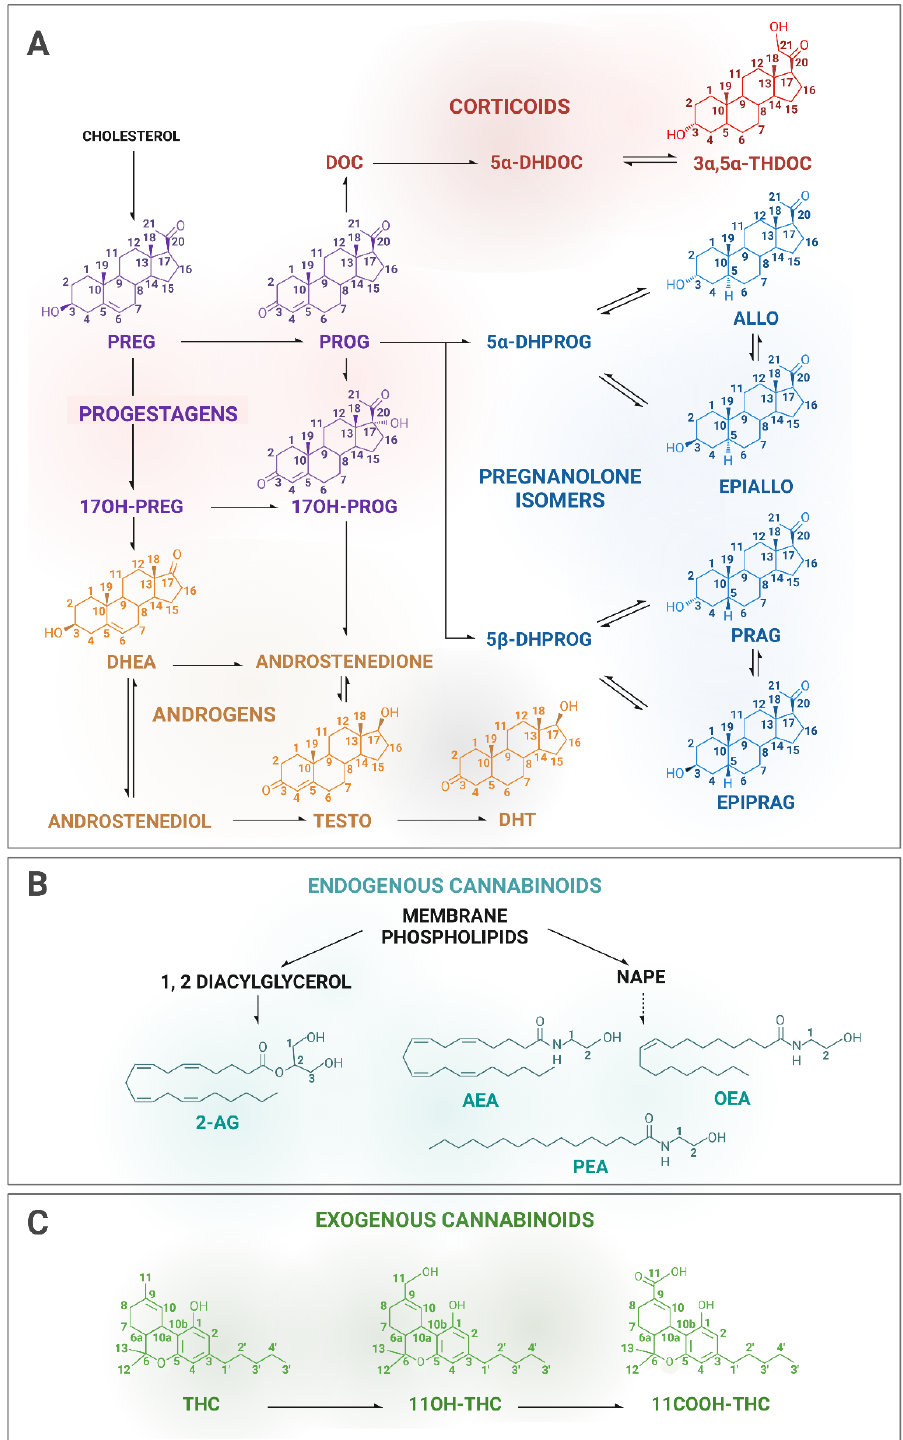
Figure 2. Structures and metabolic pathways of the targeted molecules. The steroids of interest include four progestagens (PREG, PROG and its 17hydroxy metabolite), one corticoid (3 α ,5 α‐THDOC), four pregnanolone isomers (ALLO, EPIALLO, PRAG and EPIPRAG), and two androgens (TESTO and DHT) ( A ). The cannabinoids of interest include two endocannabinoids (AEA and 2-AG), and two related fatty acids (OEA and PEA) ( B ) and the exogenous cannabinoid THC and its two metabolites (11OH ‐ THC and 11COOH ‐ THC) ( C ). Not all metabolic pathways are represented. See abbreviations in the abbreviation section.